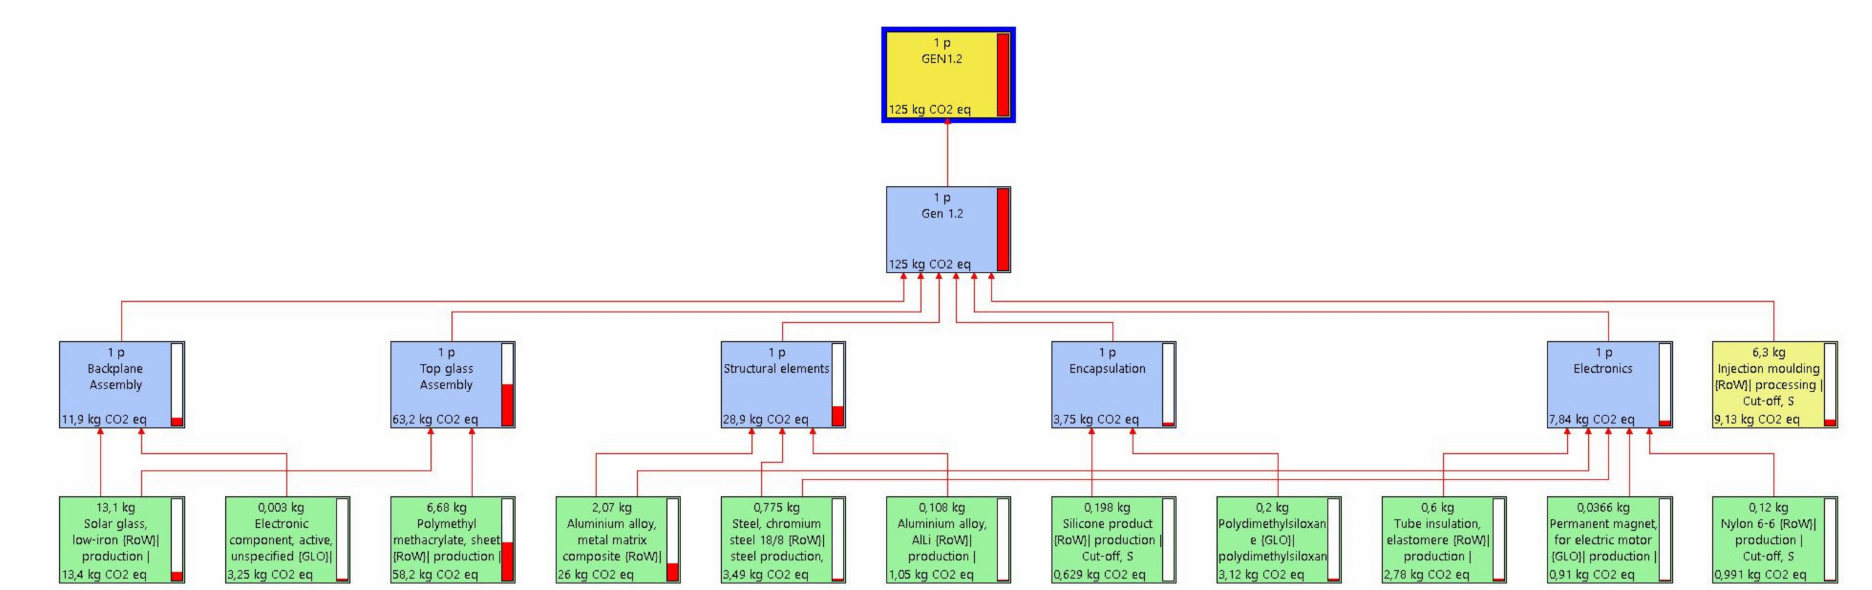
Figure 2. Reduced process tree showing emission of CO 2 eq of individual materials used to manufacture the module for